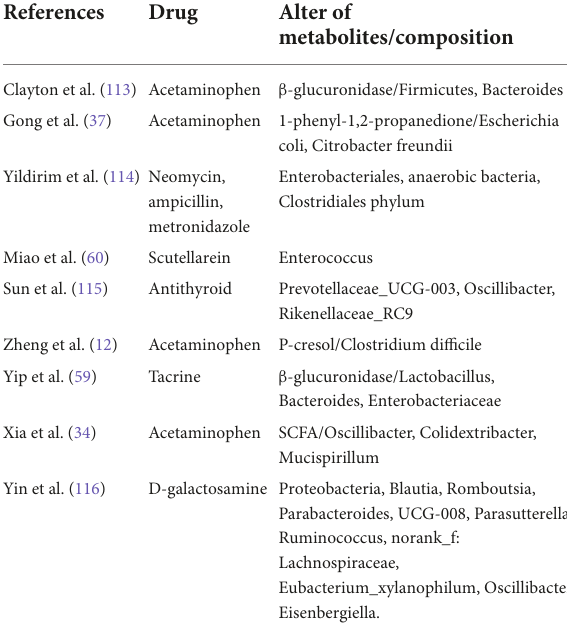
TABLE 1 List of main alteration of metabolites/composition in drug induced liver